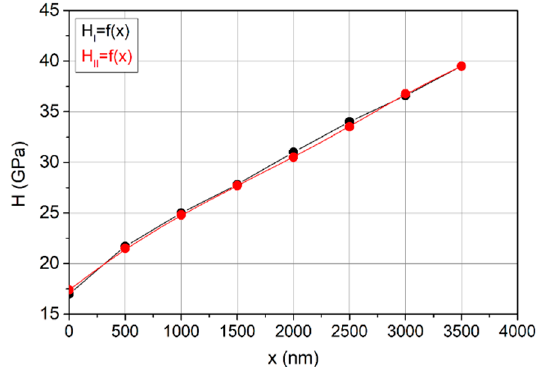
Figure 9. Comparison of profiles of hardness changes in coatings determined on the basis of square root carbon content profiles determined in the range of 0–50 at.% and 50–85 at.%.